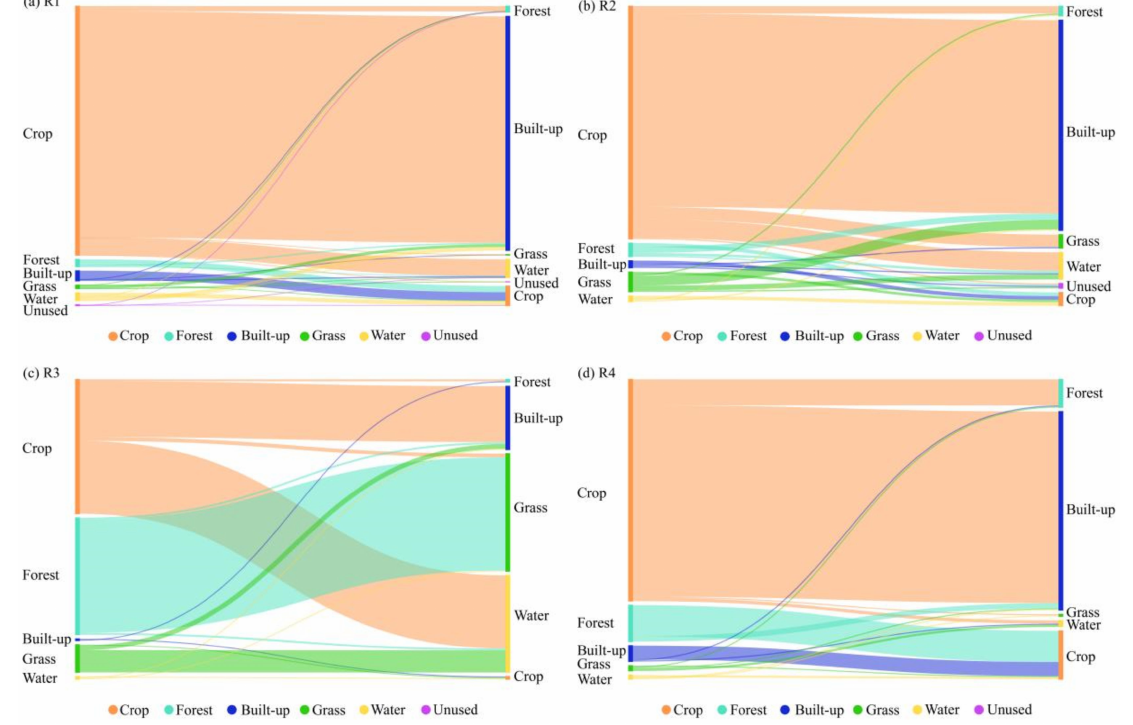
Figure 4. The flow pattern of LUCC in Henan Province from 2010 to 2015.